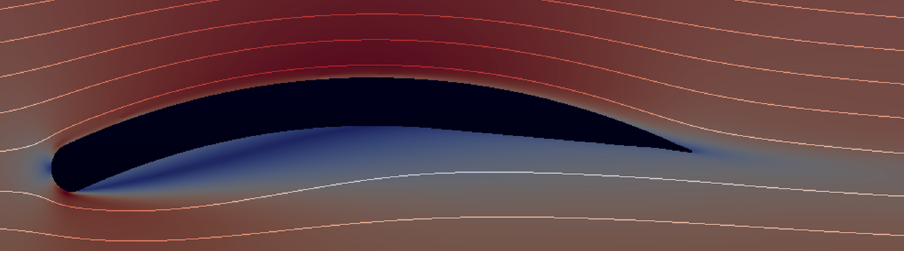
Figure 7. Contour map of flow velocity (85 m/s) of the Plate profile for zero degree angle of